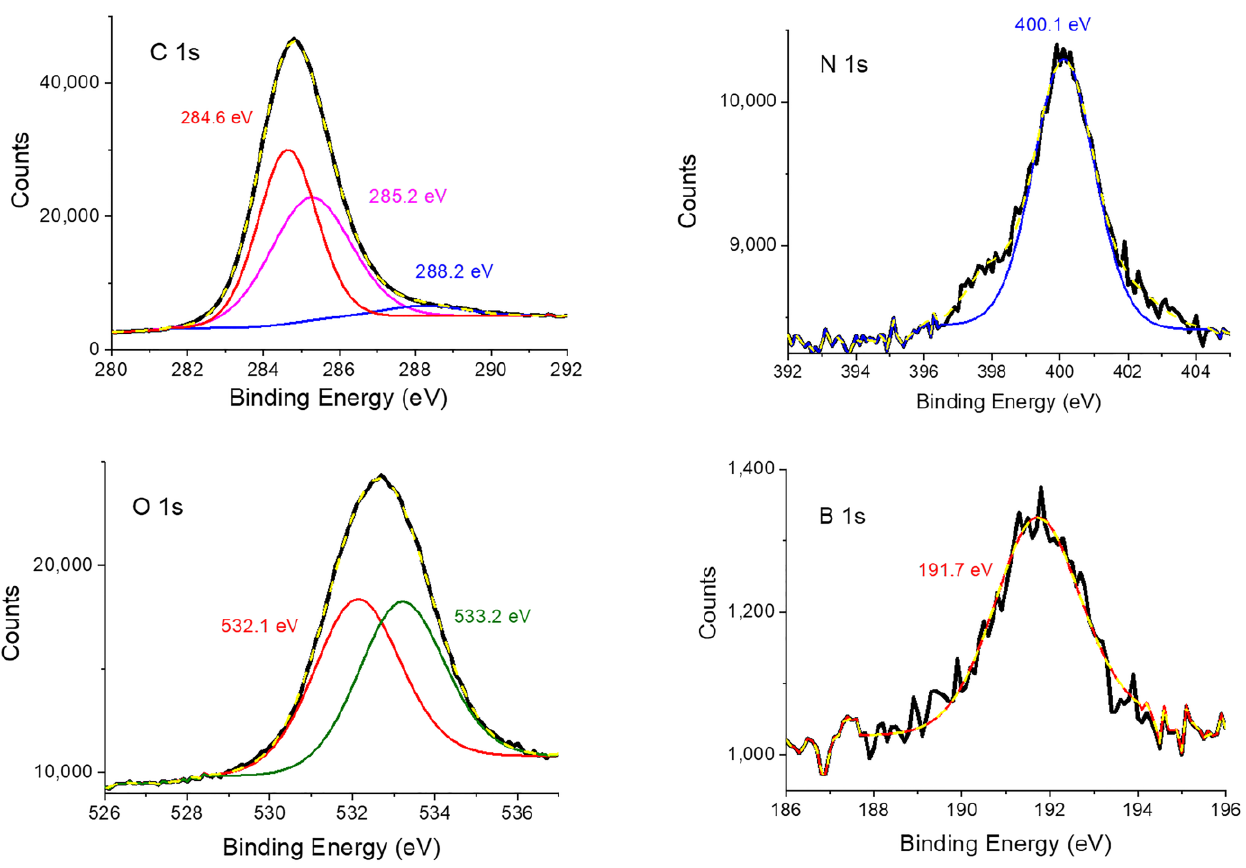
Figure 4. XPS experiment and fitting curves of C 1s, N 1s, O 1s, and B 1s for Porph-UOZ-COF. To complete the Porph-UOZ-COF characterization, the solid-state 11 B NMR spectrum [41,42] of the sample was also recorded (Figure 5). As shown in Figure 5, the COF shows two distinct signals that arise probably from either the C 2 O 2 B ring (mainly) or the B 3 O 3 ring [43,44]. The presence of B peaks in the XPS and solid-state 11 B NMR indicates the formation of O-B bonds caused by the condensation of DHPP with DBBA, confirming further COF synthesis.